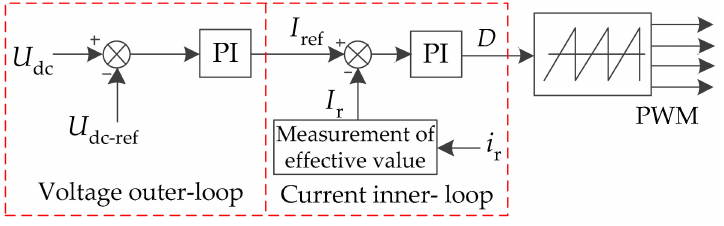
Figure 4. Double closed-loop